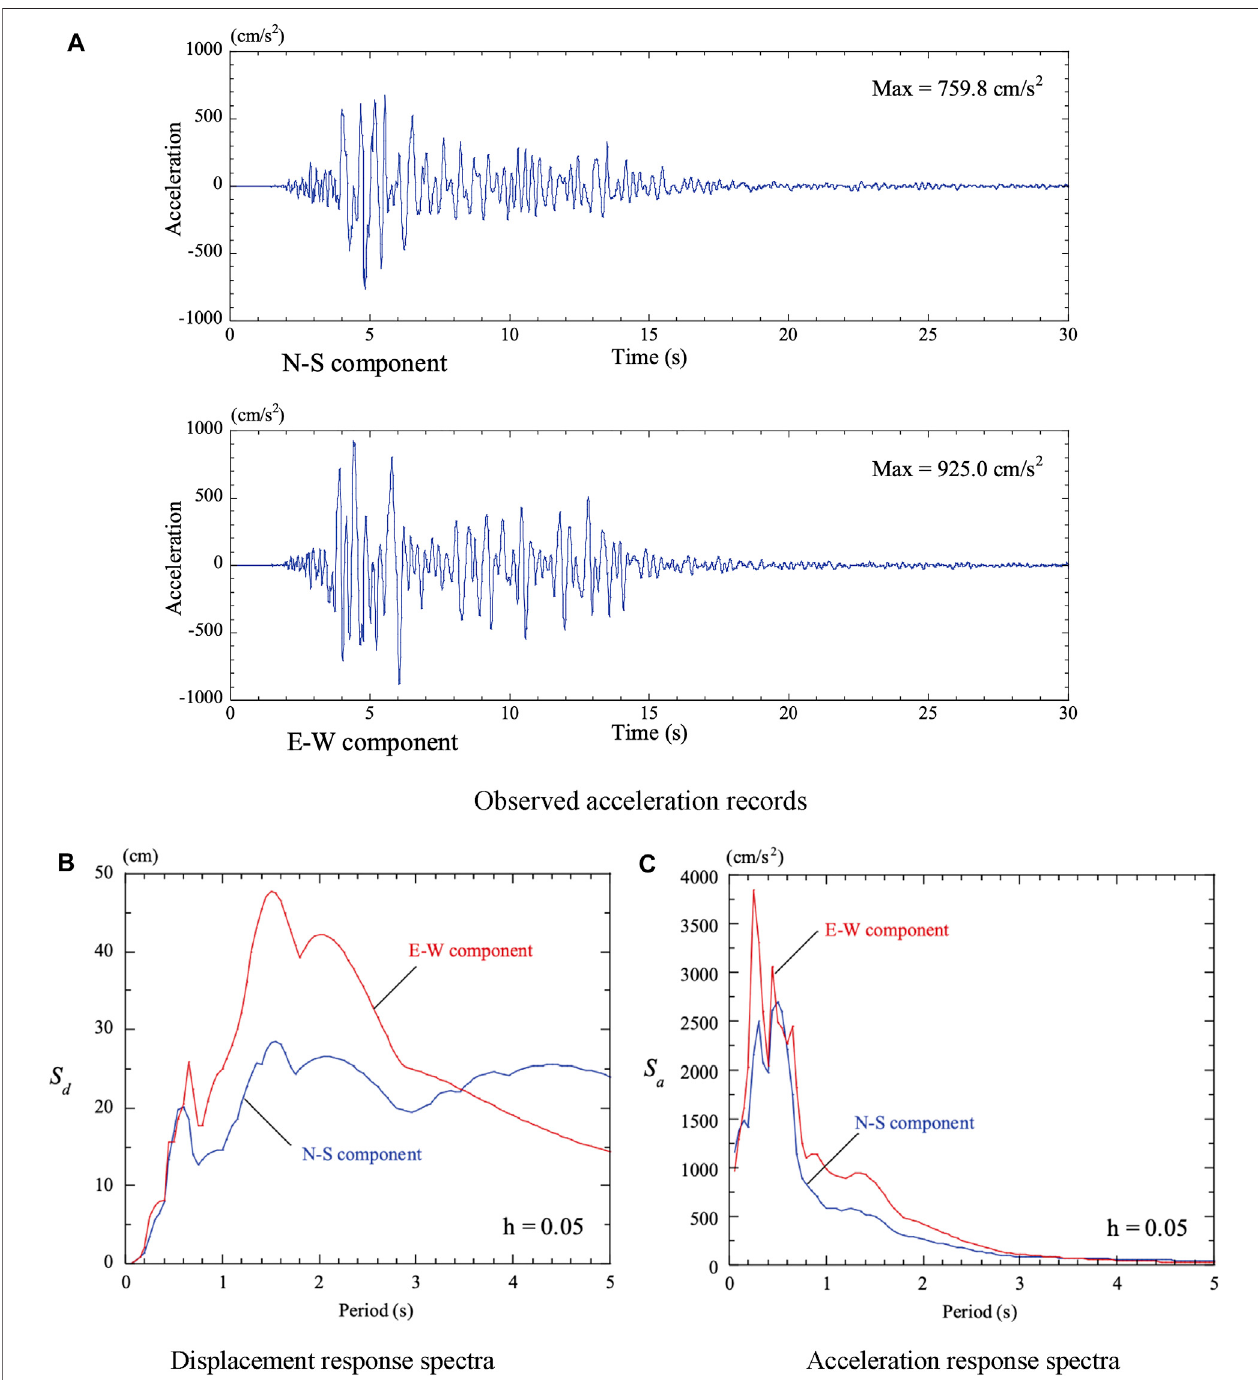
FIGURE 4 | Foreshock of the 2016 Kumamoto earthquake (on April 14, 2016). (A) Observed acceleration records. (B) Displacement response records. (C) Acceleration response records.